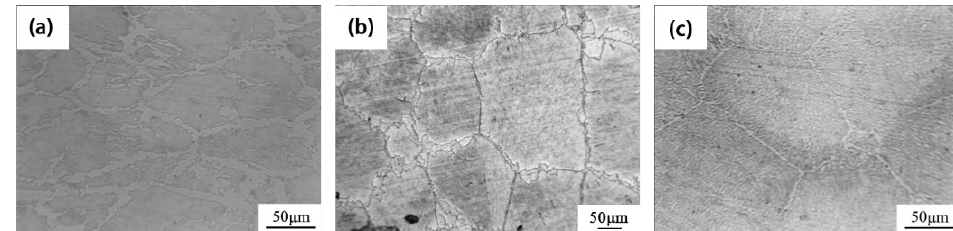
Figure 4. Optical microstructures near the fracture tips of different samples tested at 750 °C for ( a ) steel 1; ( b ) steel 2; and ( c ) steel 3.